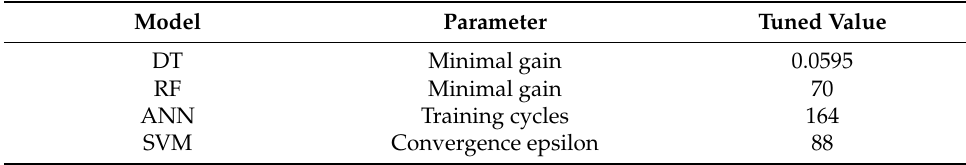
Figure 12. Convergence epsilon tuning results for SVM model. Table 3 summarize the obtained results after the parameters tuning for all four models. We notice that the minimal gain for Decision Tree tends to engender the lowest relative error with a value of 0.0595; while for Random Forest it produces the best performance with a value of 70. The Artificial Neural Network model presents best results when the training cycles equal 164. The convergence epsilon is estimated to 88, giving the lowest RMSE value for the Support Vector Machine model. Table 3. Parameter tuning results. Model